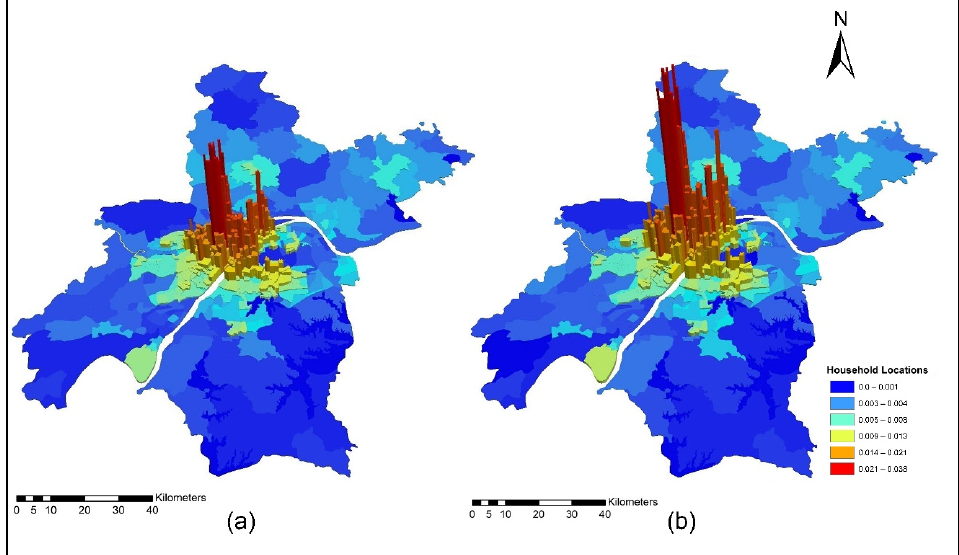
Figure 9. ( a , b ) ISE-estimated household locations: ( a ) during the morning peak for the year 2012; ( b ) during the morning peak for the year 2015.